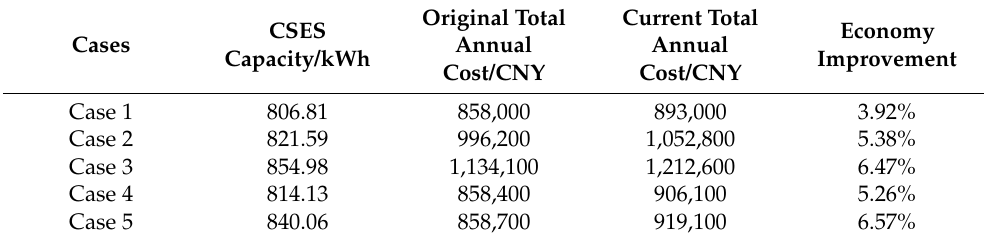
Table 8. Simulation results for different cases.